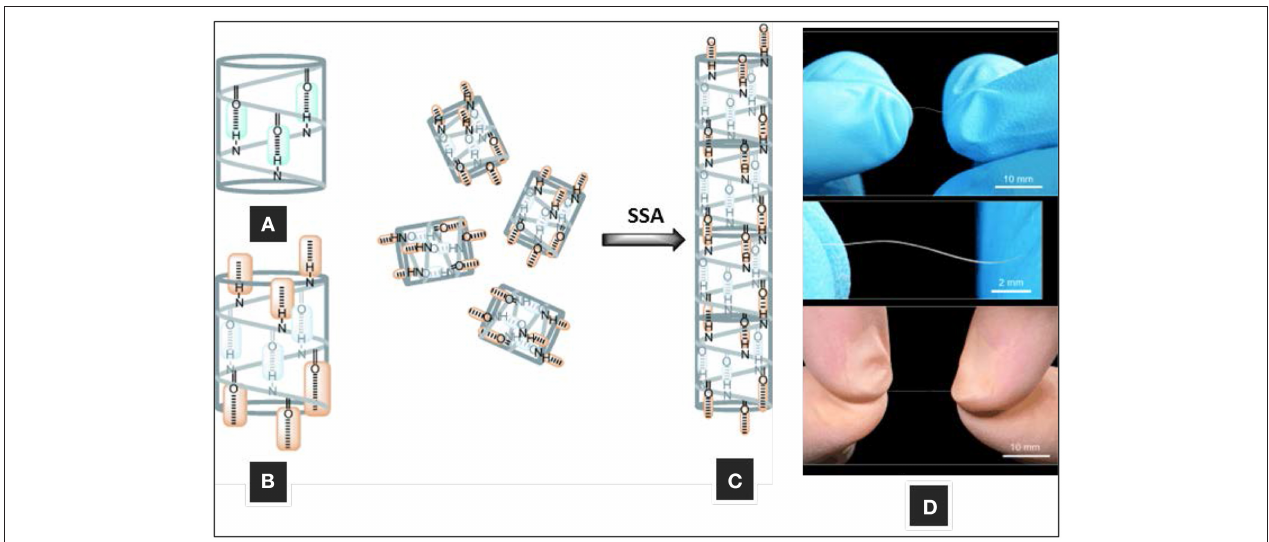
FIGURE 7 | Self-assembly of 14-helical β 3 -peptides. (A) Intramolecular hydrogen bonding motif for helix stabilization, (B) intermolecular hydrogen-bonding motif (C) fiber formation by head-to-tail hydrogen bonding, and (D) macroscopic fibers formed by β 3 -hexapeptide A C -WKVWEV-OH. Adapted with permission from Del Borgo et al. (2013). Copyright 2013 John Wiley &